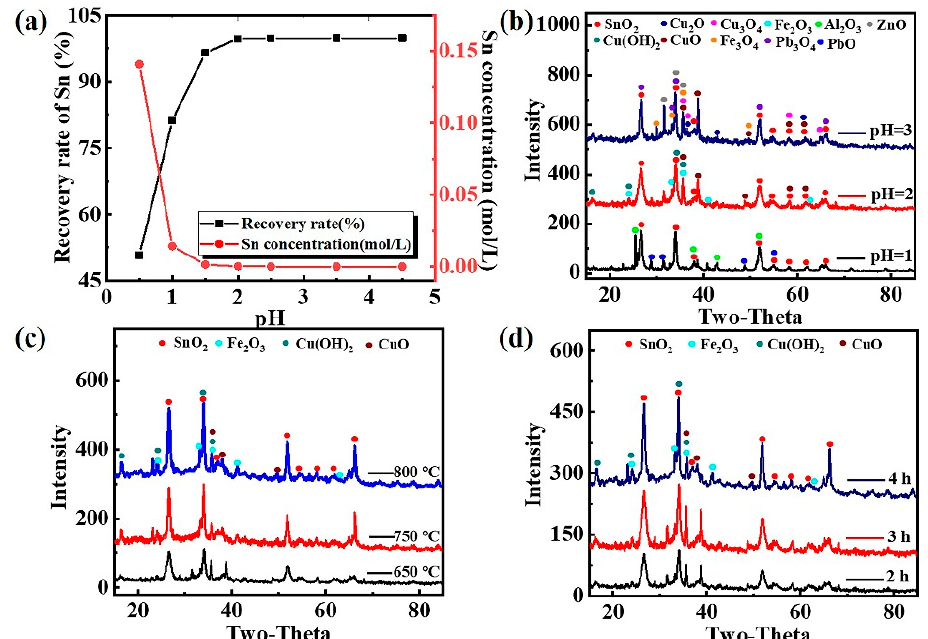
Figure 7. ( a ) The effect of pH values on the recovery rate of Sn and stable concentration of Sn, ( b ) the effect of pH values on the calcinating products at 750 °C. ( c ) The effect of roasting temperature on the roasting products (calcinating 3 h). ( d ) The effect of calcinating time on the roasting products at 750 °C.